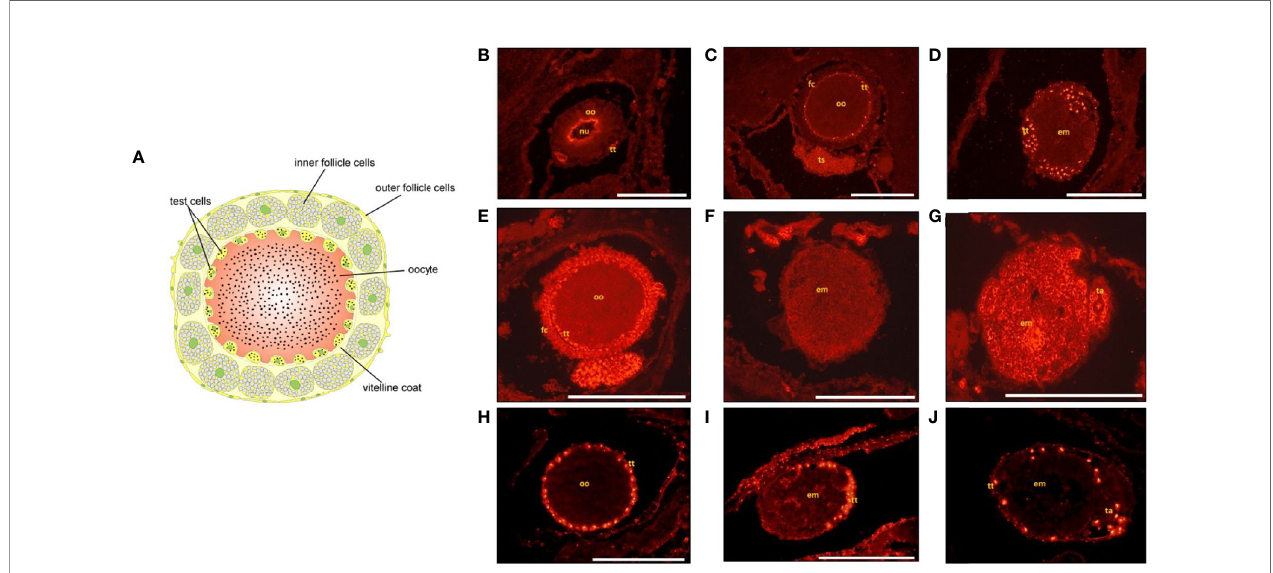
FIGURE 6 | (A) Scheme of Ciona robusta oocyte showing the envelopes surrounding it. Test cells are located under the vitelline coat. Right: immunohistochemical analysis of Botryllus schlosseri oocytes (B , C , E , H) and embryos (D , F , G , I , J) with Vasa (B – D), PI10 (E – G) and IAP antibodies (H – J) . Bar=250